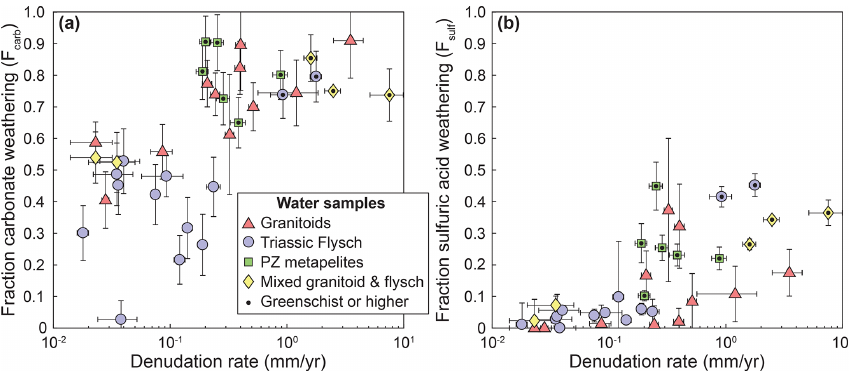
Figure 6. Fraction of carbonate weathering and weathering by sulfuric acid. (a) Fraction of carbonate weathering (Eq. 23). (b) Fraction of weathering by sulfuric acid (Eq. 24). Symbols indicate catchment lithology. Catchments underlain by different lithologies are distinguished by symbols and color. Data points with a black dot are metamorphosed to greenschist facies or